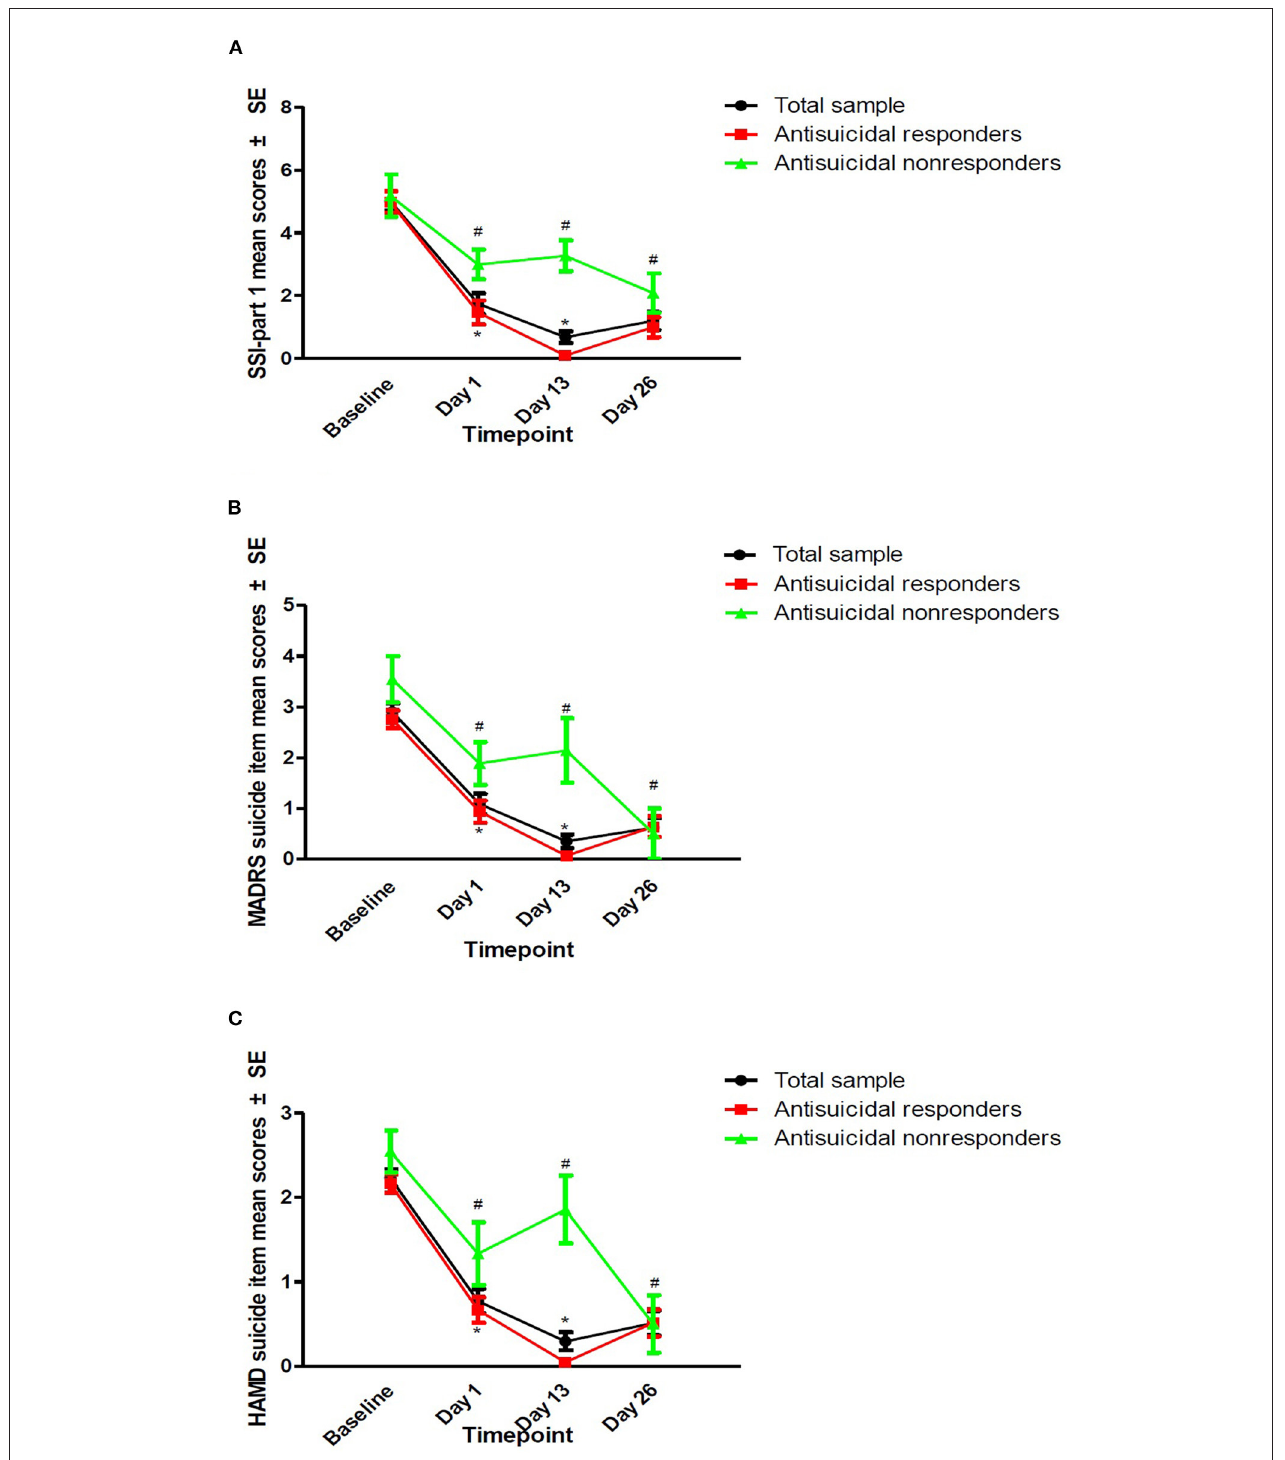
FIGURE 1 | The antisuicidal effects of ketamine were measured by SSI part I, the MADRS suicide item, and the HAMD suicide item. The antisuicidal effects of ketamine as measured by SSI part I (A) , the MADRS suicide item (B) , and the HAMD suicide item (C) . #A significant difference was found compared to the baseline at the indicated times ( P < 0.05). *A significant difference was found between antisuicidal responders and non-responders at the indicated times ( P < 0.05). SSI, the Beck Scale for Suicide Ideation; MADRS, the Montgomery-Åsberg Depression Rating Scale; HAMD, the Hamilton Depression Rating Scale.